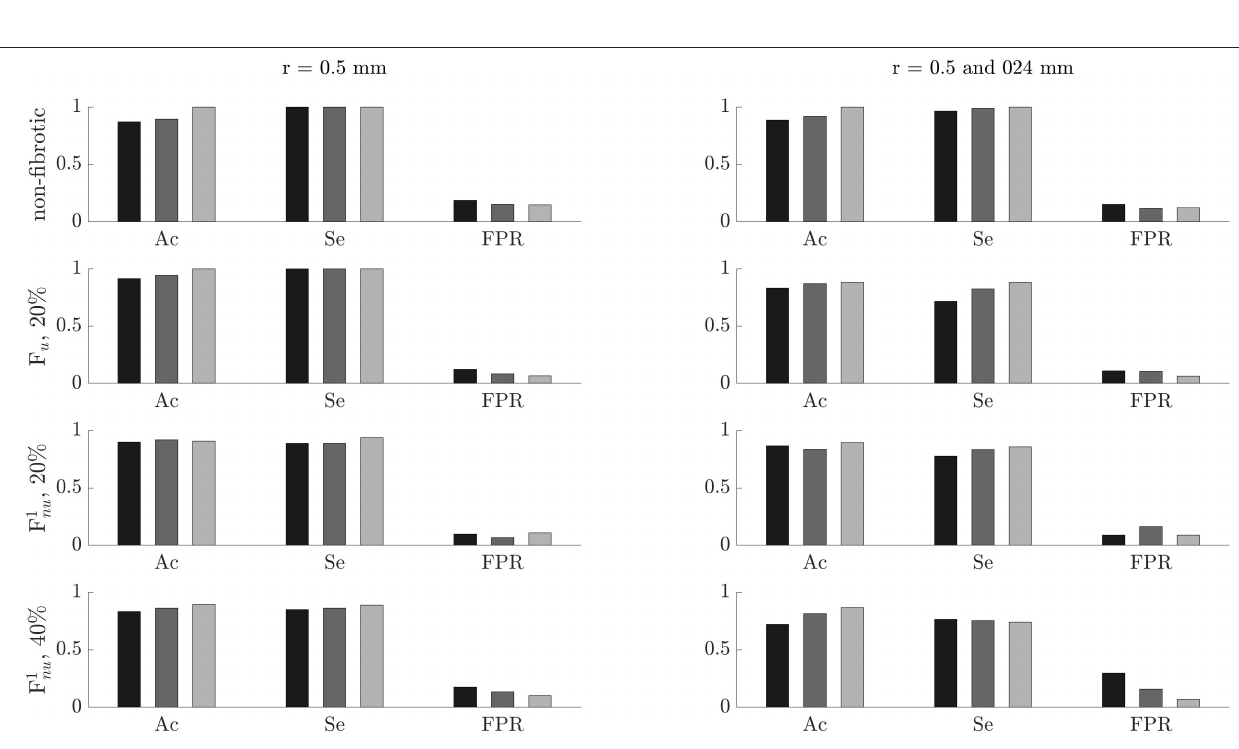
Frontiers in Physiology |